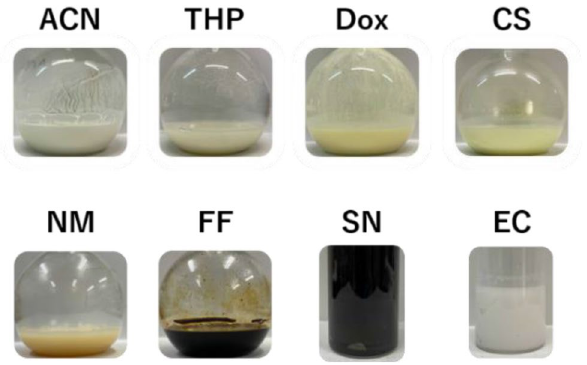
Figure 1. Photographs of 70Li 2 S–30P 2 S 5 mixtures after stirring for 3 days in ACN, THP, Dox, CS, NM, FF, AN, and EC